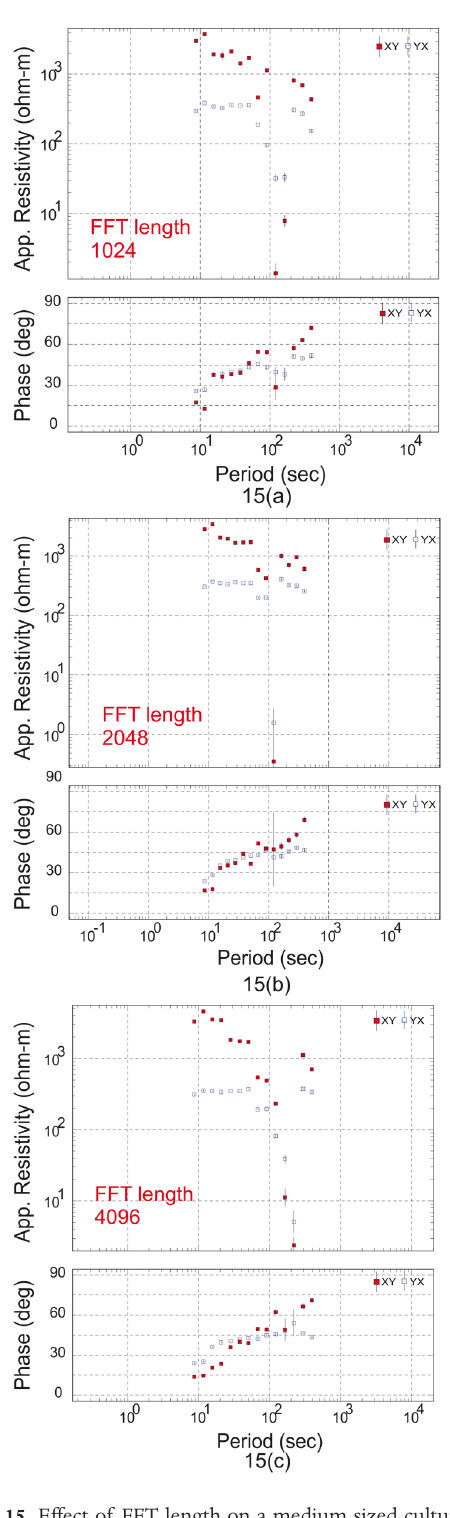
Figure 15. Effect of FFT length on a medium sized culturally af- fected noisy data set of 2S sampling frequency of site K11 with 154,587 dada points. (a) Apparent resistivity (upper panel) and phase (lower panel) curves obtained from the data using a FFT length of 1024. (b) Apparent resistivity (top panel) and phase (bottom panel) curves obtained applying a FFT length of 2048 on the same data set. (c) Apparent resistivity (top panel) and phase (bottom panel) curves obtained applying a FFT length of 4096. FFT length 2048 provides a better outcome as this FFT length can give optimal num- ber of stacks for this medium sized disturbed data set. The red col- ored boxes represent XY components and the blue colored boxes represent YX components of apparent resistivity and